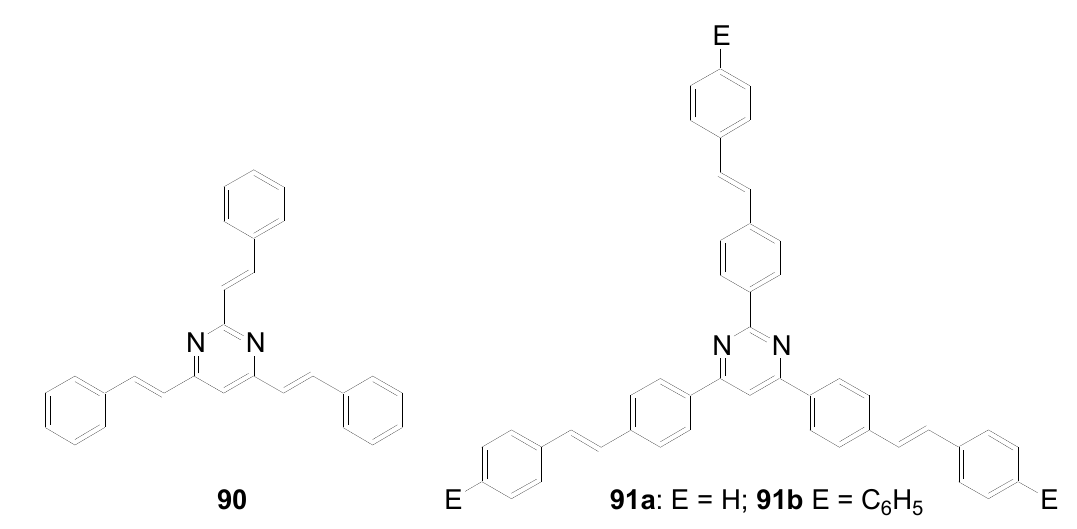
Figure 28. 2,4,6-Trisstyryl- and